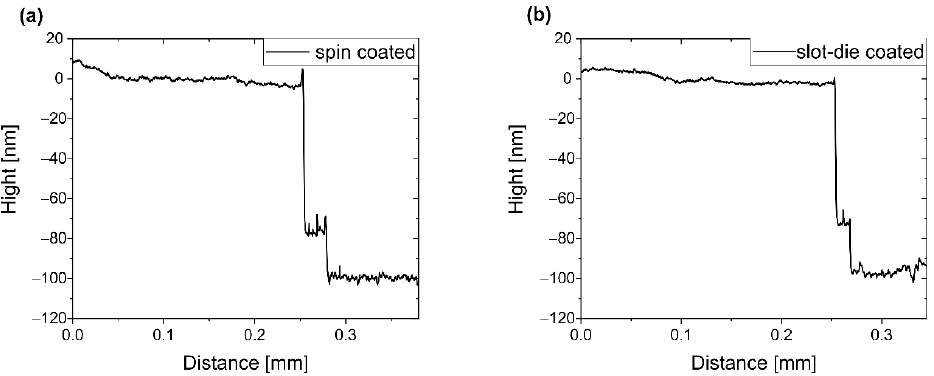
Figure 3. Profilometry diagrams of emissive layer (PVK:PBD + Ir) deposited from anisole:chlorobenzene mixture, by spin coating ( a ) and slot-die coating ( b ). Emissive layer deposited on PEDOT:PSS/ITO. The first downcast refers to PEDOT:PSS layer, and the second one to the ITO anode.